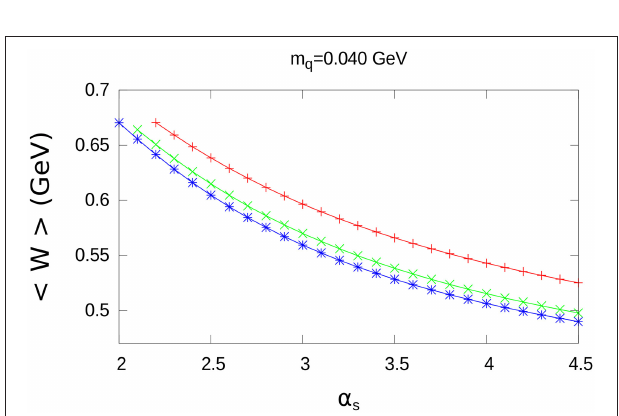
FIGURE 6 | Value of W as a function of α s . The same conventions as in the previous figures are used.